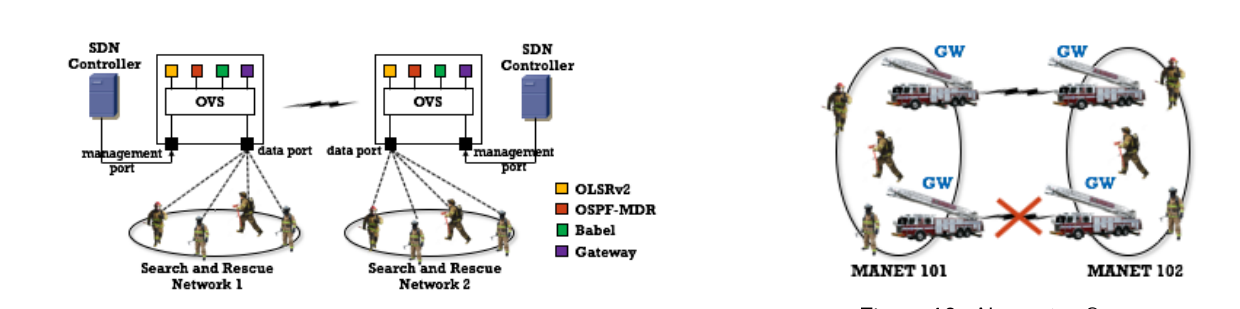
Figure 18. Alternative